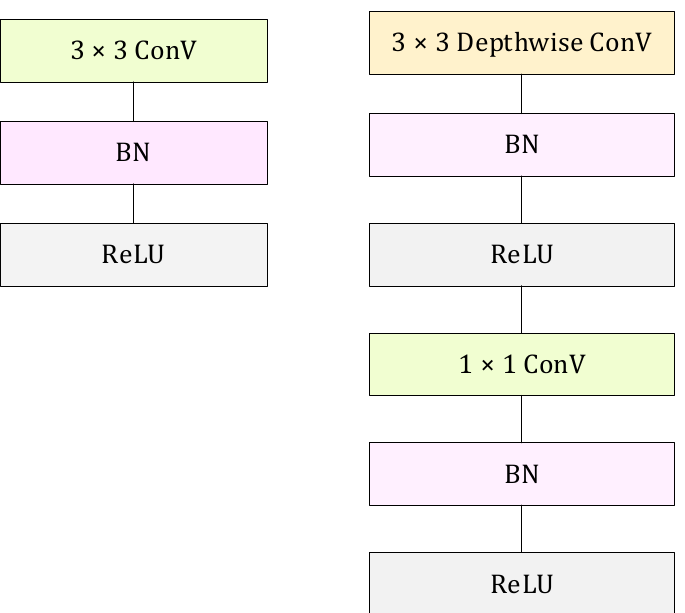
Figure A1. A standard convolution ( left panel ) and a depth-wise separable convolution ( right panel